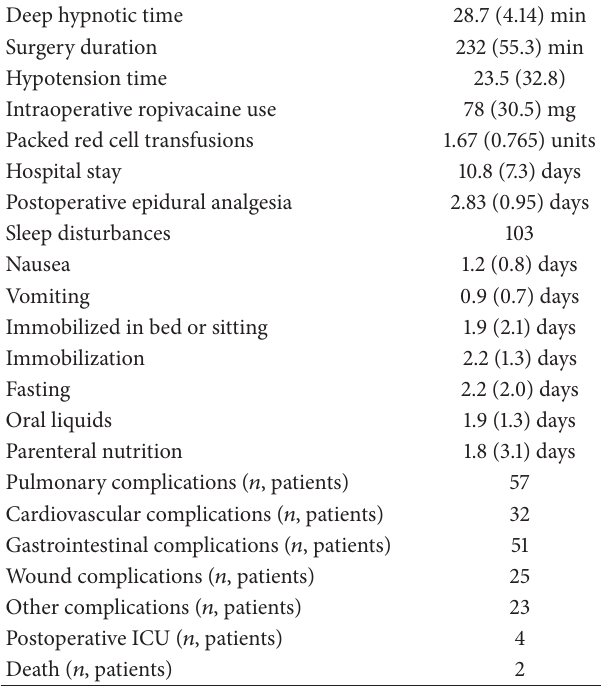
Table 2: Intraoperative and postoperative